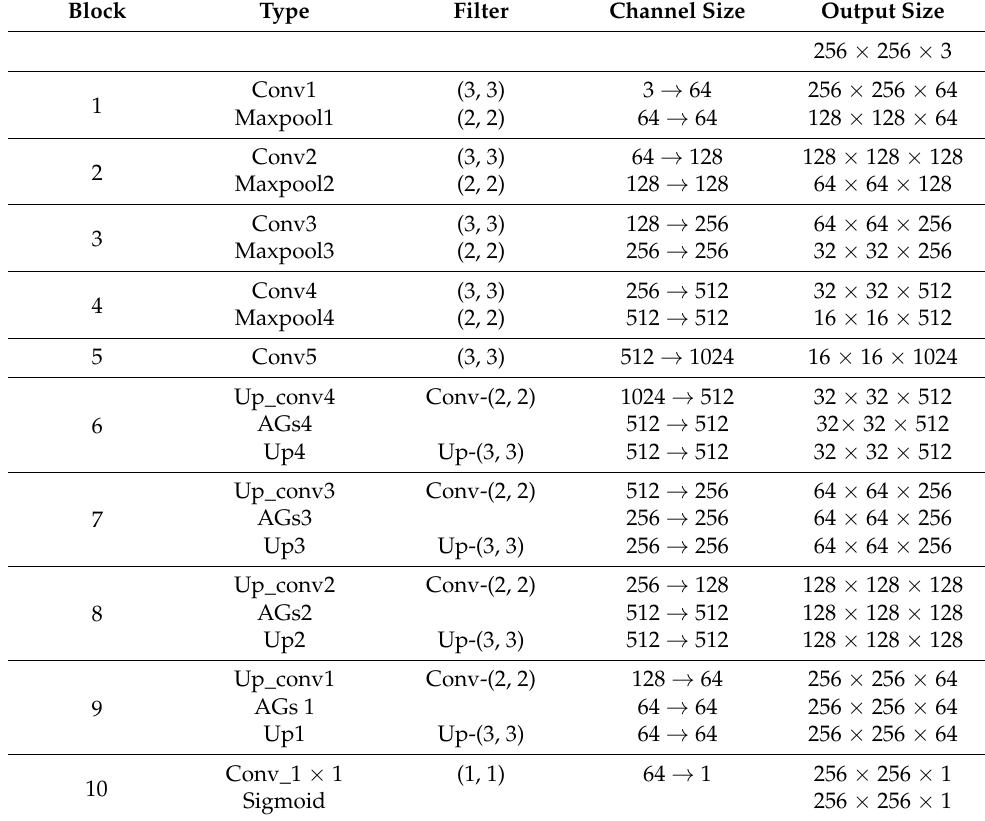
Table 1. Detailed blocks of the proposed AGs-Unet outlined in Figure 1. Block Type